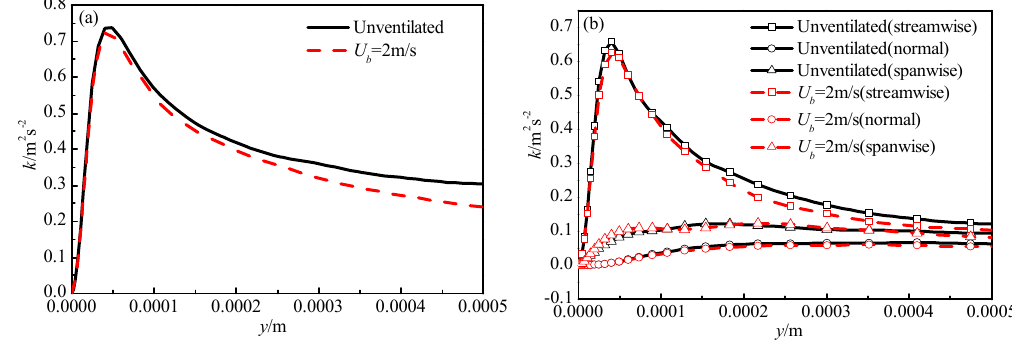
Figure 17. Average distribution of turbulent kinetic energy along the normal direction: ( a ) total turbulent kinetic energy and ( b ) component of turbulent kinetic energy.